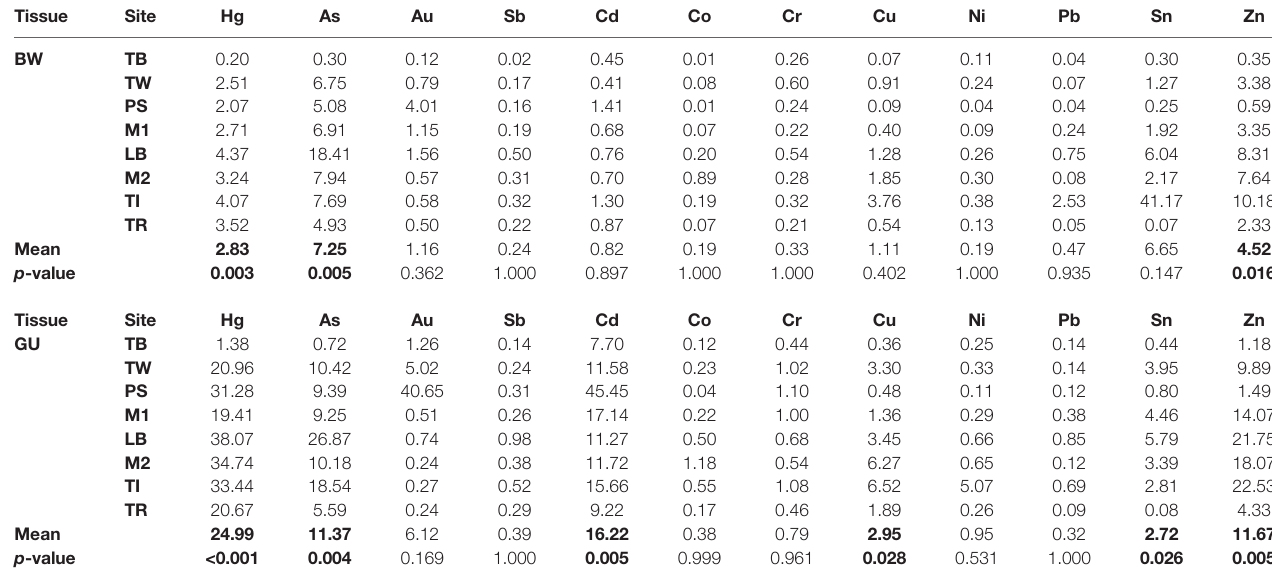
TABLE 2 | Biota-sediment accumulation factors (BSAFs) for each element in body wall (BW) and guts (GU) at each site: Totok Bay (TB); Talawaan River (TW); Pantai Surabaya (PS); West Bangka mangroves (M1); Lihunu Bay (LB); North-west Bangka mangroves (M2); Tumbak Island (TI); Tasik Ria Resort (TR). Tissue Site Hg As Au